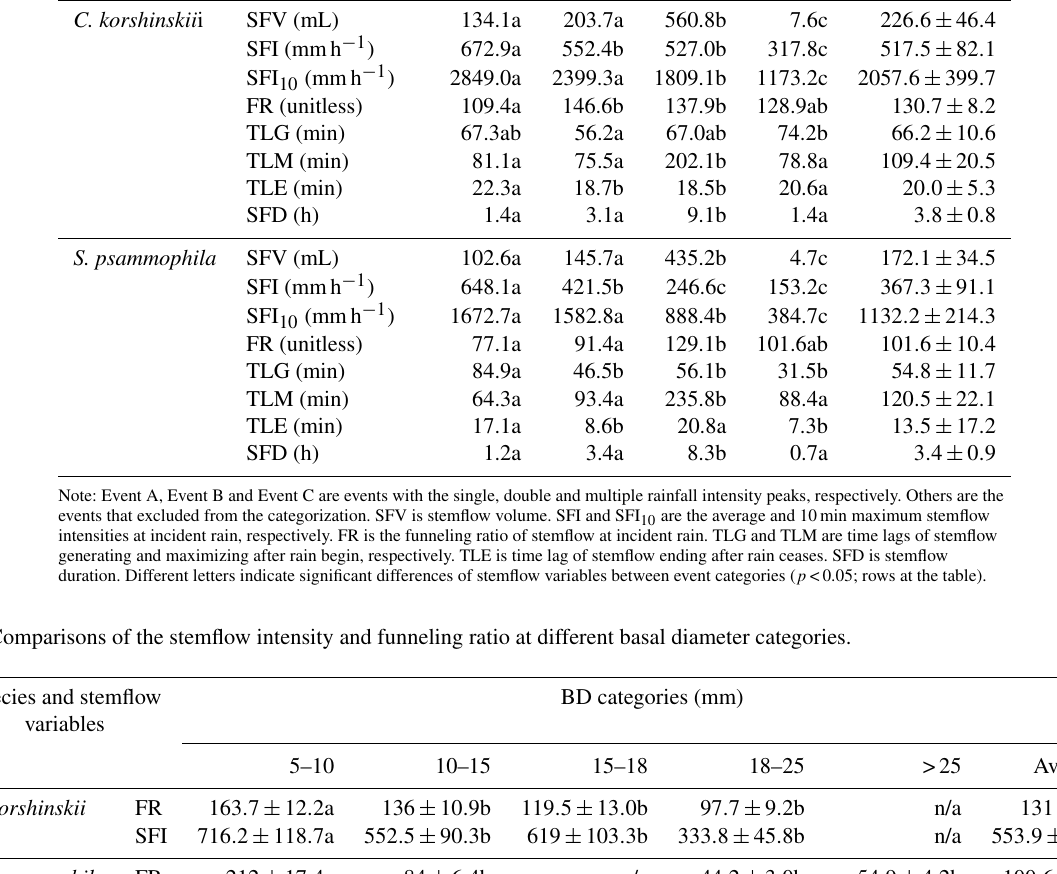
Table 3. Stemflow variables of C. korshinskii and S. psammophila during rainfall events with different intensity peak amounts. Species